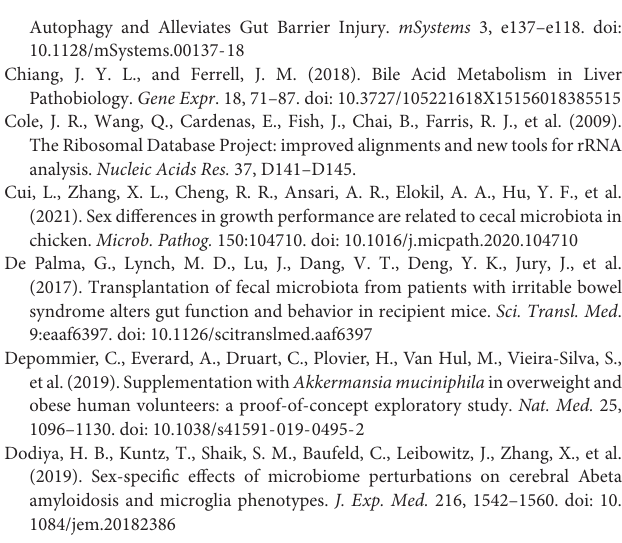
increased, indicating that our sampling depth was adequate to cover the fecal microbial composition we tested. Supplementary Figure S2 | Box-and-whisker plots of alpha diversity indices (Chao1 and Shannon) for fecal microbial communities in saline (Con, n=8), fresh rumen fluid (FR, n=8) and sterilized rumen fluid (SR, n=8) cows. Kruskal-Wallis was performed to analyze alpha diversity indices difference across all groups. Supplementary Figure S3 | The dynamic distributions of fecal microbiota at phylum (A) and genus (B) levels. The IDs on the X-axis represent the samples from Con, FR and SR groups. C = saline, Con group; FR = fresh rumen fluid; SR = sterilized rumen fluid. Supplementary Figure S4 | Partial least squares-discriminate analysis (PLS-DA) scores plot between Con and FR, Con and SR, FR and SR groups based on LC/MS. Con = saline, FR = fresh rumen fluid, SR = sterilized rumen